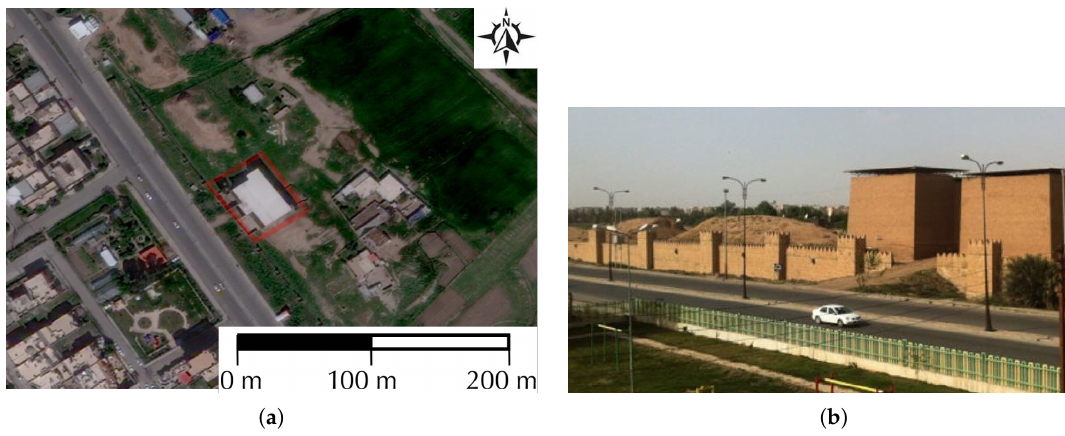
Figure 31. Overview of Mashki Gate before the destruction: ( a ) GeoEye-1, 1 April 2016 c (cid:13) DigitalGlobe; and ( b ) ground view (April 1990)